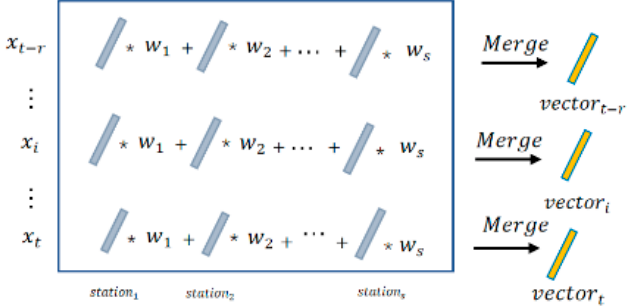
Figure 5. Vector merge operation.